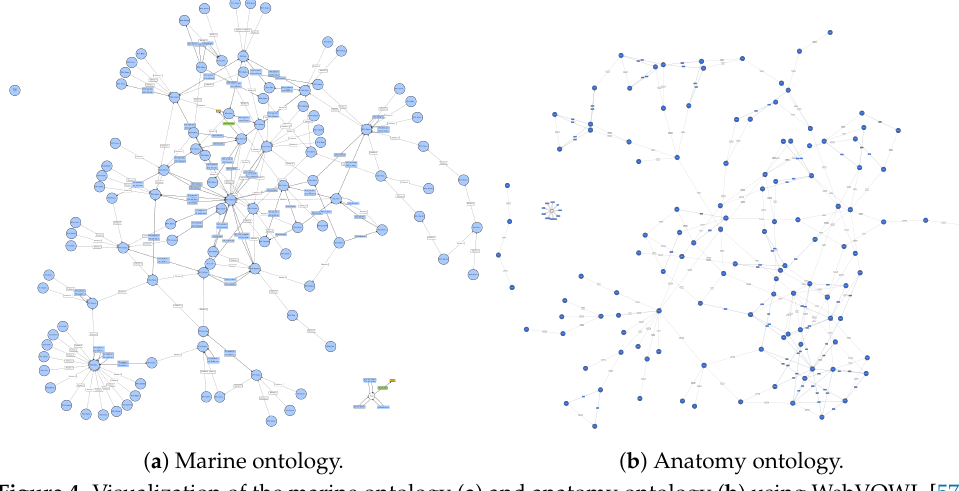
Figure 4. Visualization of the marine ontology ( a ) and anatomy ontology ( b ) using WebVOWL